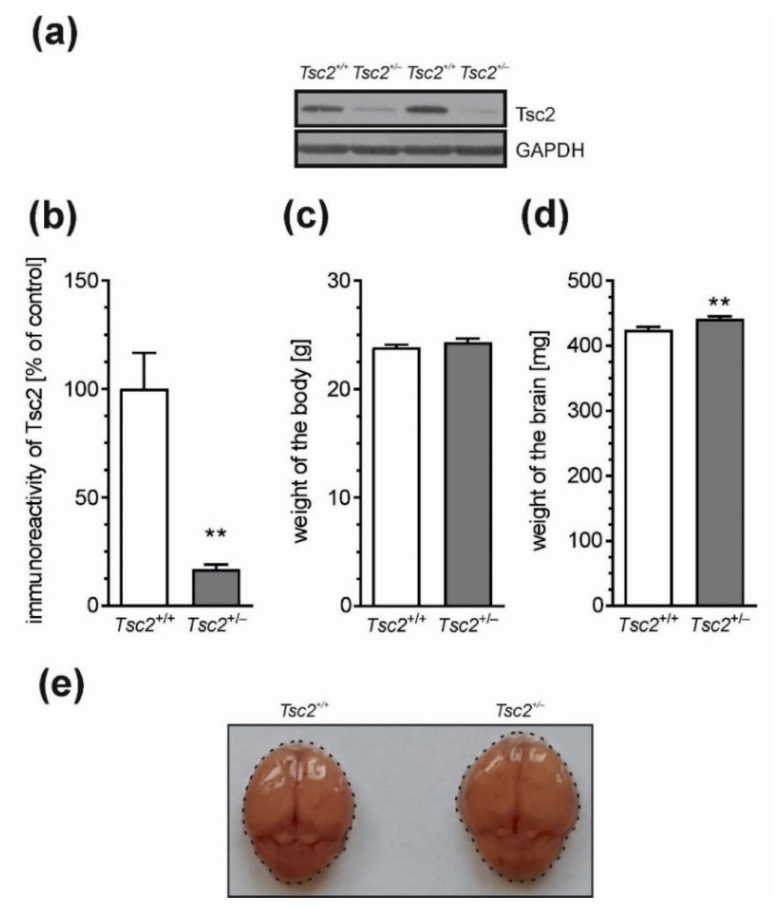
Figure 1. The effect of Tsc2 haploinsufficiency on body weight in mice. ( a ) The protein level of Tsc2 in the brain cortex of Tsc2 +/+ and Tsc2 +/ − two-month-old male mice was analysed by Western blotting. Typical blots are presented. ( b ) Densitometric analysis of immunoreactivity of Tsc2 in the brain cortex. Data were normalised to GAPDH. n = 3. ( c , d ) The effect of Tsc2 insufficiency on the body weight and brain weight. ( e ) Example photographs of the brains of Tsc2 +/+ and Tsc2 +/ − two-month-old male mice. n = 30. Data represent the mean values ± SEMs. ** p < 0.01 vs. wild-type animals, as determined by Student’s t